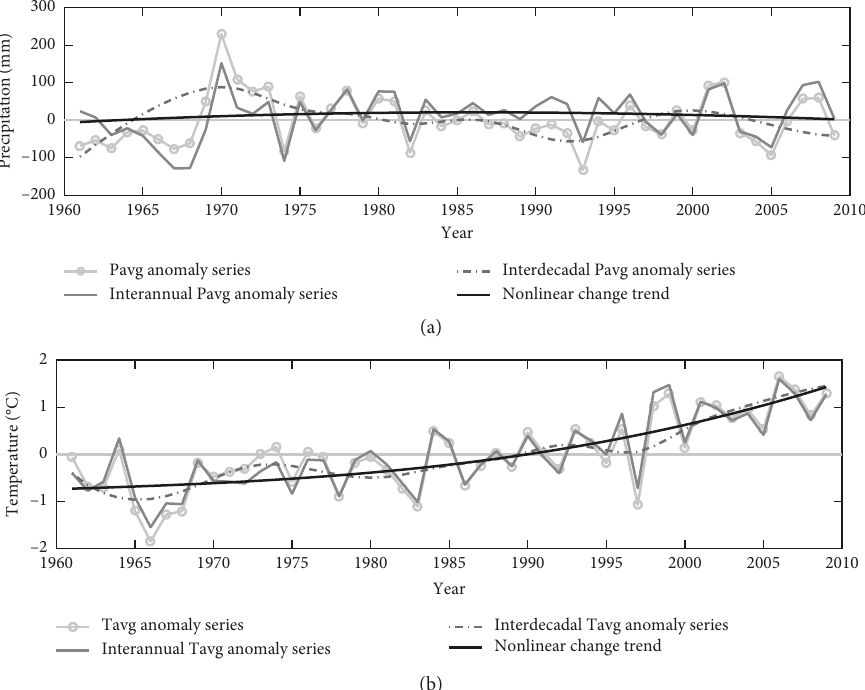
Figure 4: Interannual and interdecadal fluctuations as well as nonlinear change trends of Pavg anomaly series (a) and Tavg anomaly series (b) during 1961–2009 over the upper reach of the YZRB.